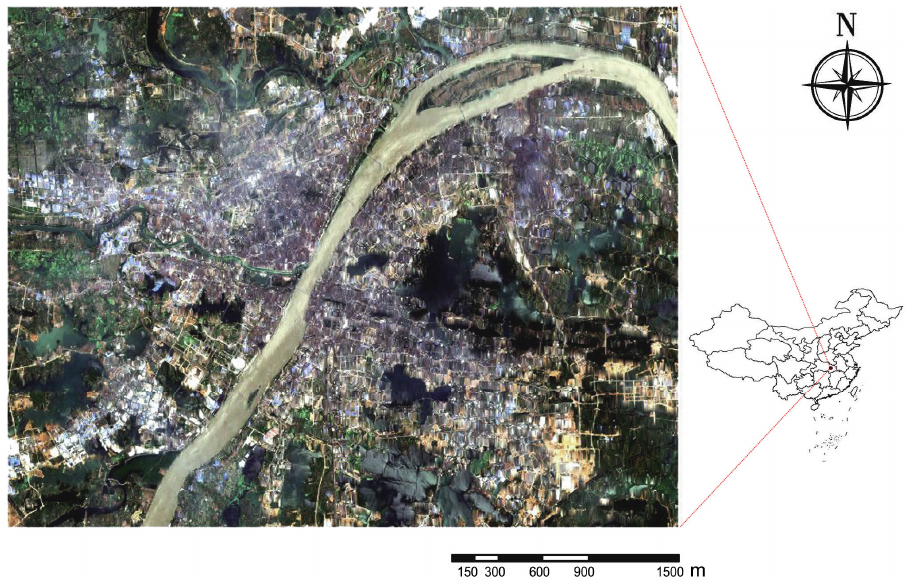
Figure 1. The study area represented by Landsat 7 ETM+ image (RGB) on 17 May 2012.